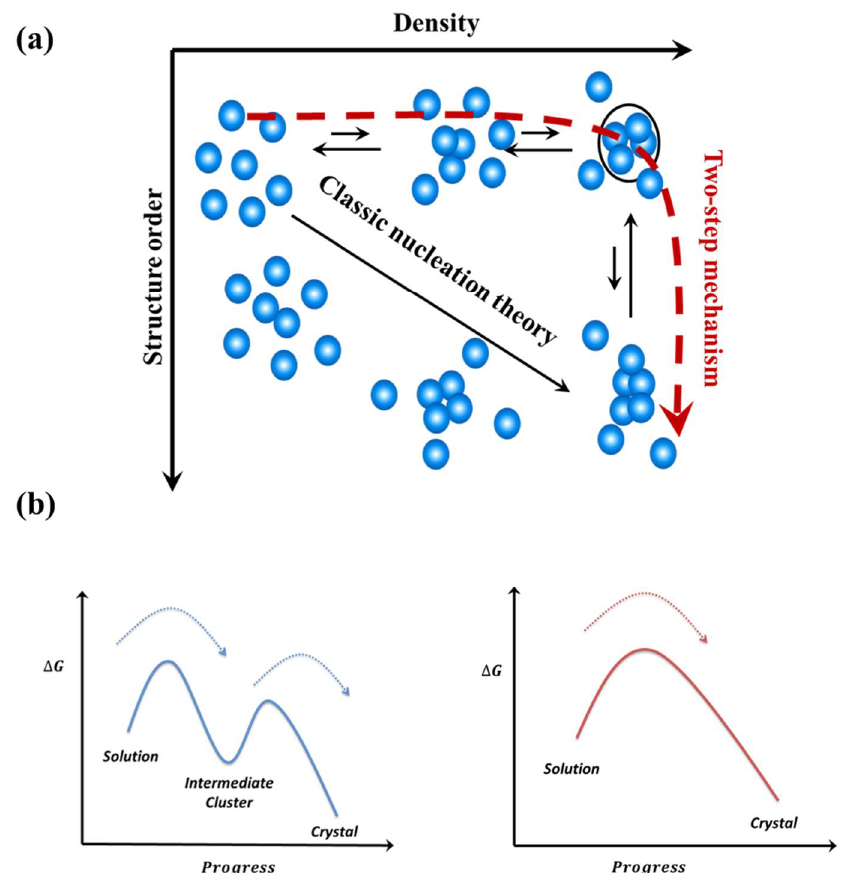
Figure 3. The two-step nucleation mechanism: ( a ) Comparison of nucleation pathways of the two- step mechanism with CNT. Reprinted/adapted with permission from [72]. Copyright 2017, copyright Vekilov, P.G. et al. Copyright©2004, American Chemical Society. ( b ) Comparison of free energy along the pathway of crystal nucleation followed the two-step nucleation mechanism ( left ) and CNT ( right